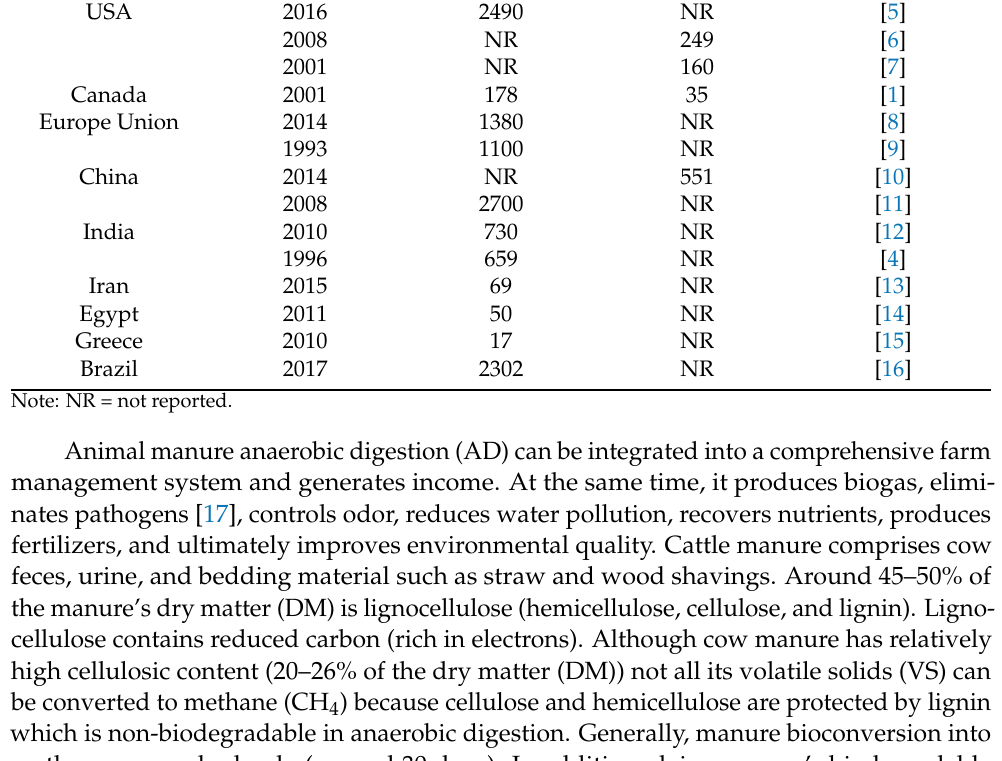
Table 1. Manure production in different countries.